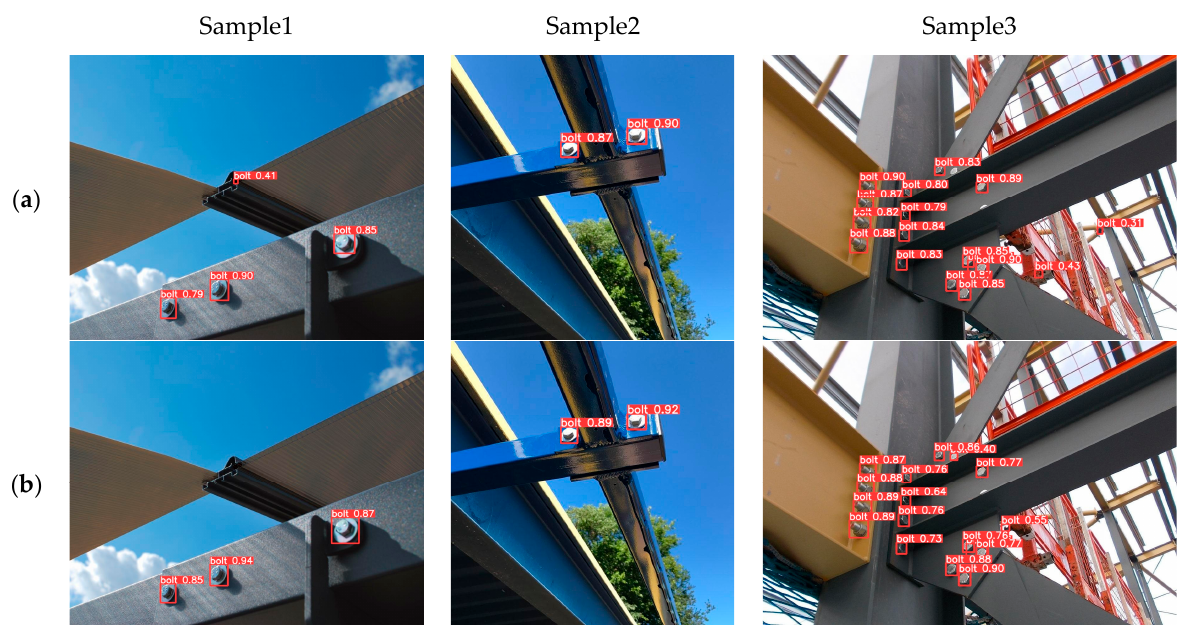
Figure 8. Visual comparison of detection results. The row ( a ): the detection result of YOLOv5x. The row ( b ): the detection result of the improved YOLOv5x.